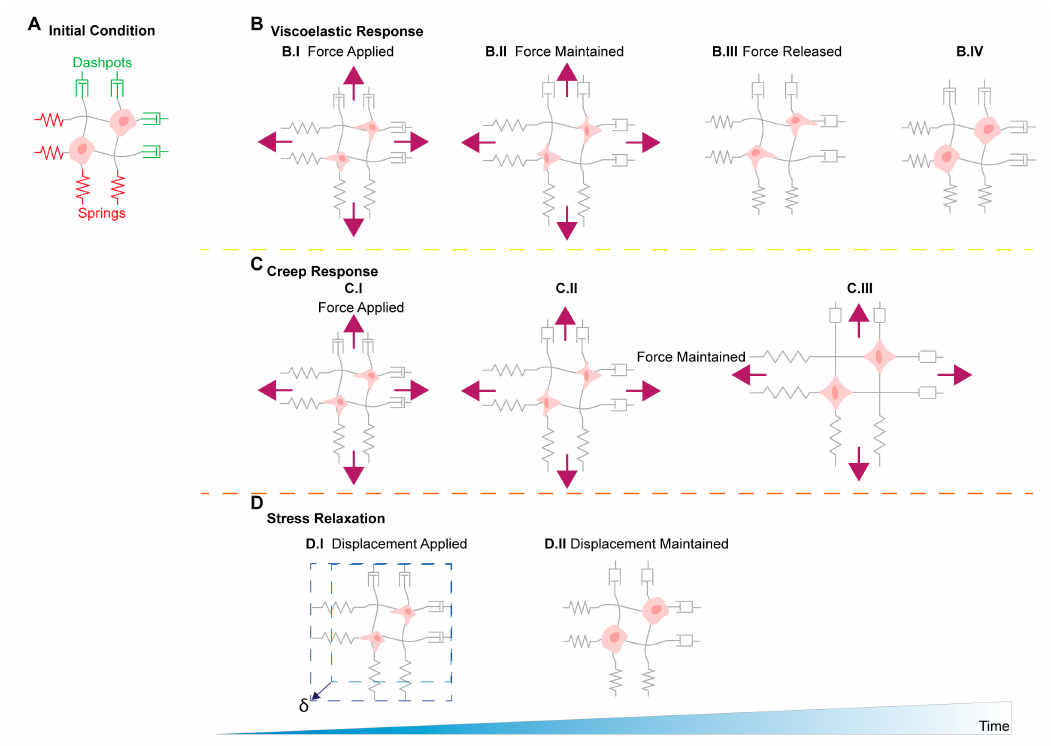
Figure 2. Spring and dashpot model to represent the viscoelastic response, creep response, and stress relaxation of the extracellular matrix in the tumor microenvironment. ( A ) Initial unstressed cellular ECM is represented by spring (elastic) and dashpot (viscous, time-dependent) model response to applied force and deformations. ( B ) Viscoelastic response characteristics of ECM. ( B.I ) Initial force application creates immediate elastic stretching of matrix components as shown through elongation of the spring components. ( B.II ) Maintenance of applied force continues to deform components in a time-dependent manner as represented by dashpots. ( B.III ) Release of force application allows for immediate elastic recoil in some components as indicated by spring recoil and time-dependent restructuring indicated by prolonged dashpot elongation. ( B.IV ) Prolonged release of force allows for complete recovery of elastic deformation and realignment of ECM structures. ( C ) Creep response. ( C.I ) Initial force application creates immediate elastic stretching of matrix components as shown through elongation of the spring components. ( C.II ) The continued application of force for prolonged time continues to deform ECM components as seen in the elongated dashpots. ( C.III ) The prolonged force stimulus denatures the ECM components creating plastic deformation or creep in the polymer networks that would not be recovered with the removal of the force. ( D ) Stress relaxation. ( D.I ) A set displacement is applied on the ECM components and no additional forces are maintained. An immediate response from elastic spring-like components stretches the material. ( D.II ) As deformation is held constant, internal stress are reduced over time as the ECM relaxes. This is mechanically demonstrated as elongation of the dashpot components, which allows for recoil in the elastic-like materials shown here as spring conformational change into resting